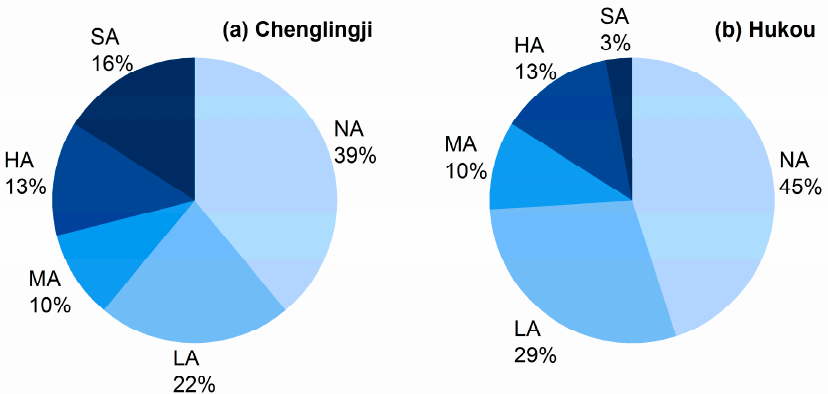
Figure 5. Distribution of hydrological indicators within the five classes of alteration for ( a ) Chenglingji and ( b ) Hukou. NA denotes no or slight alteration, LA denotes low alteration, MA denotes moderate alteration, HA denotes high alteration, and SA denotes severe alteration.